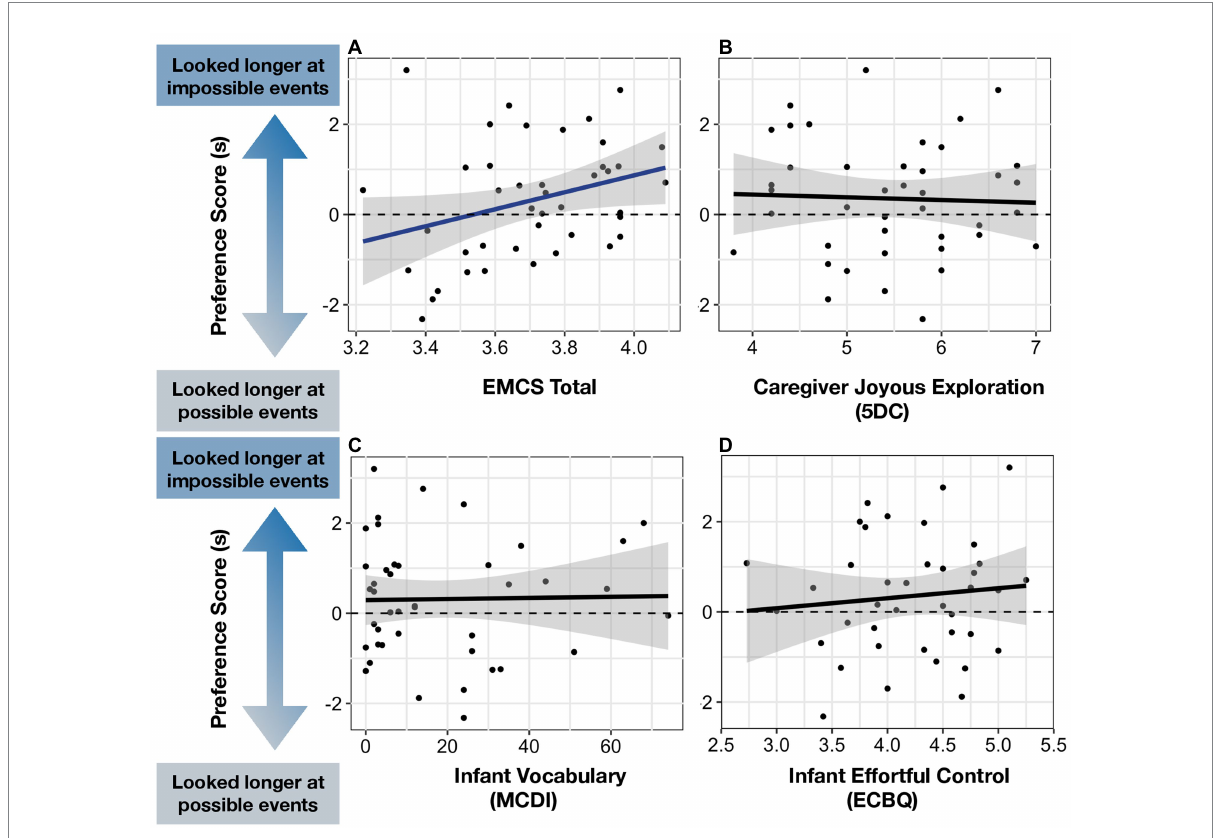
FIGURE 3 Relations between four predictors and infants’ Preference Score: (A) EMCS Total (Early Multidimensional Curiosity Scale), (B) Caregiver Joyous Exploration (5DC), (C) Infant Vocabulary (MCDI), (D) Infant Effortful Control